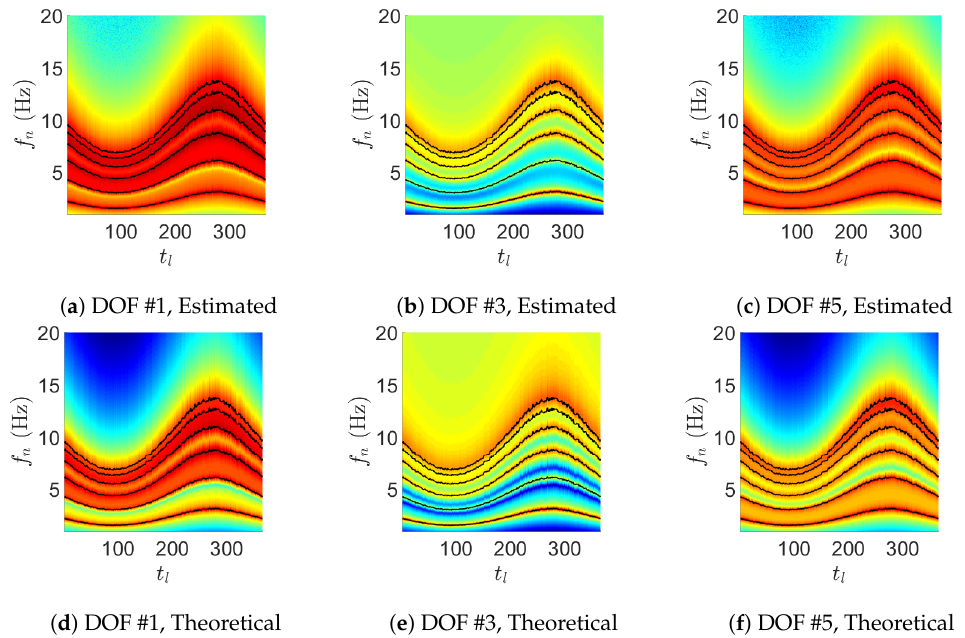
Figure 6. Spring-mass-damper: estimated (top row, Welch’s method with Hanning window, N FFT = 2 11 , 50% overlap) and theoretical (bottom row) amplitudes of the frequency response functions at measured DOFs. Continuous black curves correspond to the long time-varying natural